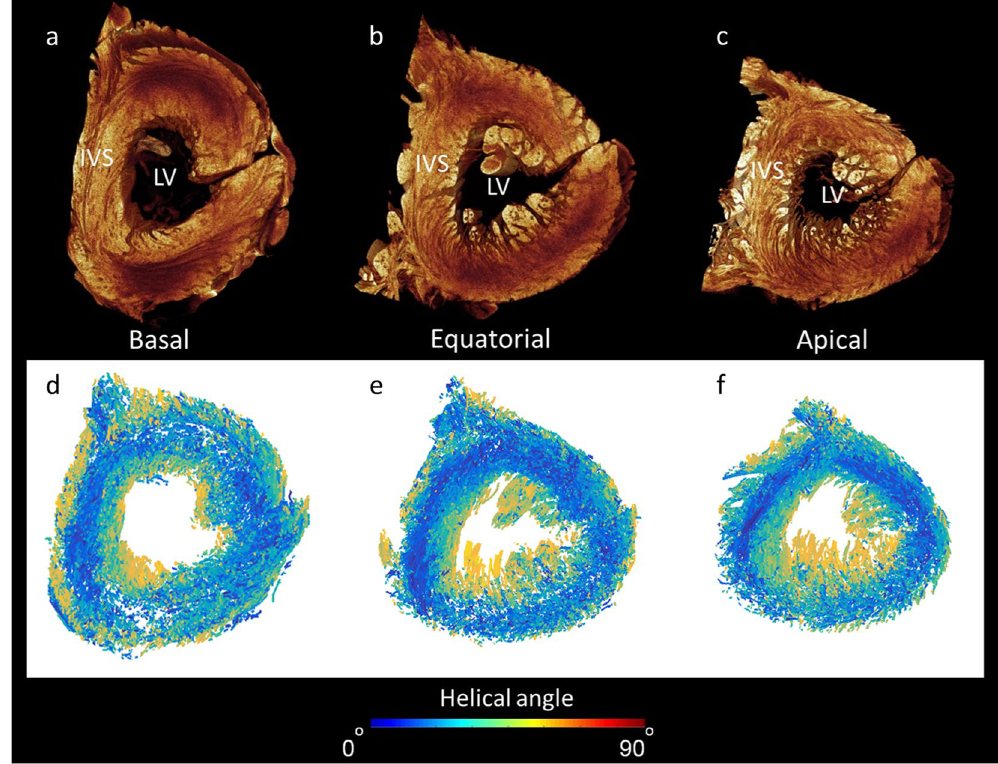
Figure 8. Extraction of cardiomyocyte orientation in the human left ventricle. Panels a–c show volume renderings in short-axis view taking from the basal, equatorial, and apical regions. Panels d–f show corresponding cardiomyocyte orientation in which the absolute helical angles derived from the CT dataset are coded in colour (see colour map). Note the right ventricular free wall is removed from view. IVS- interventricular septum, LV- left ventricular